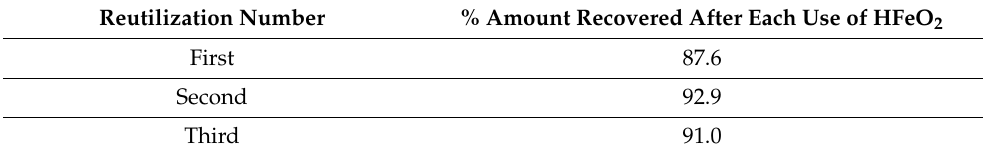
Table 3. Recovery percentage of the catalyst after use in the photo-Fenton oxidation for OMW